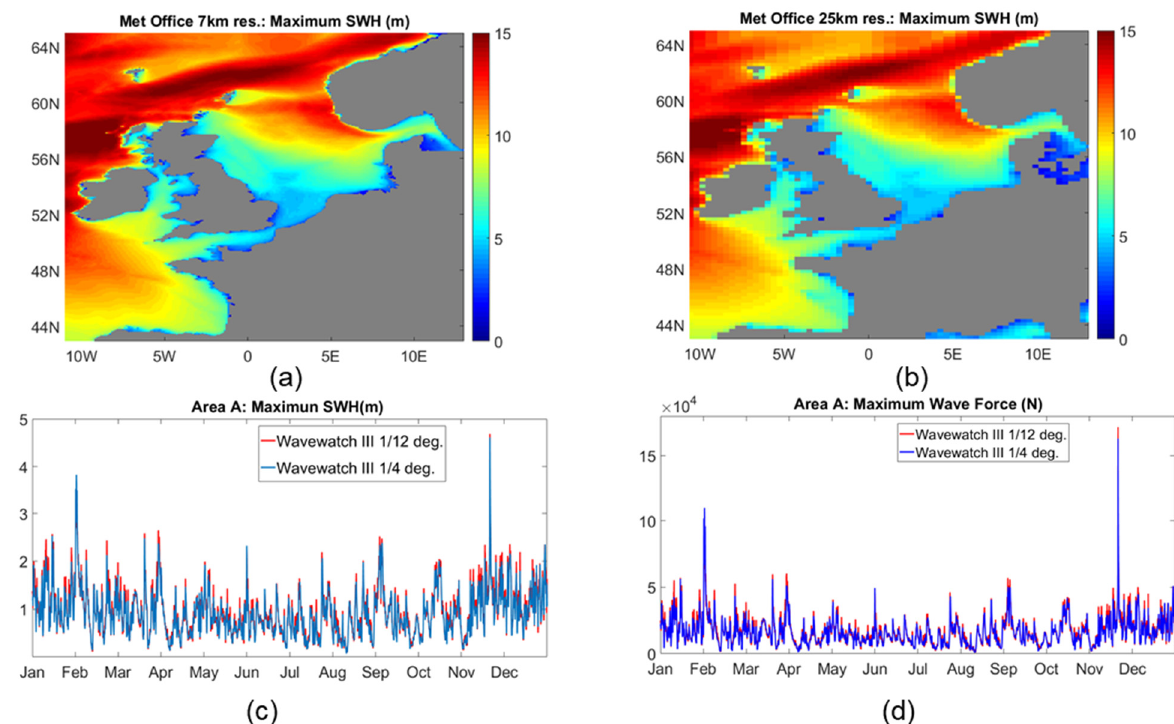
Figure 15. Spatial maps of yearly maximum significant wave height (m) from the two Met Office WaveWatch III outputs at ~7 km ( a ) and ~25 km ( b ) spatial resolution, respectively. Time series of area-averaged hourly Significant Wave Height (m) ( c ) and Maximum Wave Force (N) ( d ) in area A from July 2014 to June 2016, from the Met Office WaveWatch III model at ~7 km (red) and ~25 km (blue) spatial resolution.